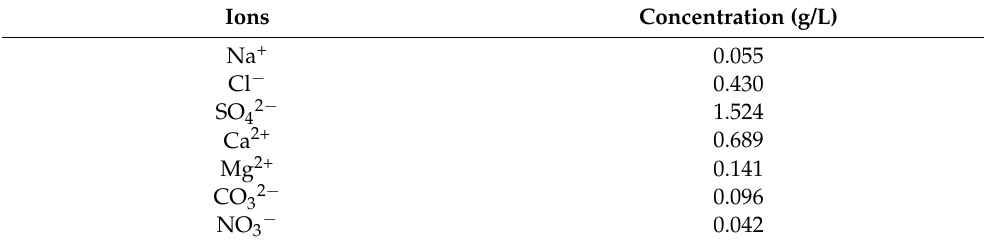
Table 2. The main ionic components of the